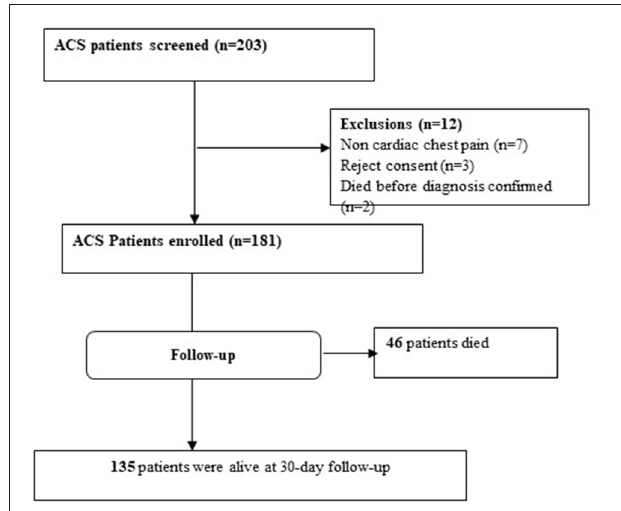
FIGURE 1 | Study flow chart of ACS patients admitted to tertiary hospitals in Ethiopia during the study period.